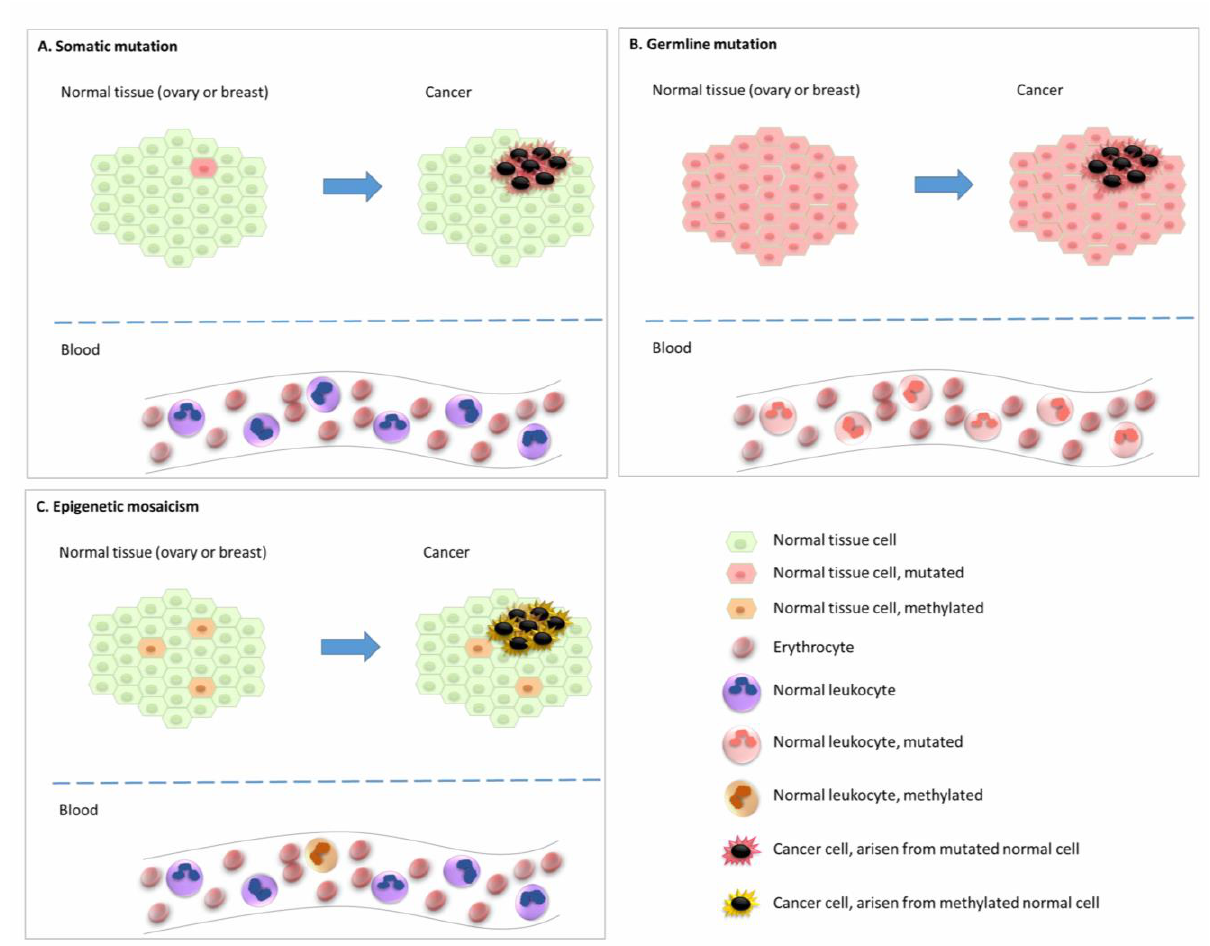
FIGURE 1: Early events underlying carcinogenesis. (A) Cancer arising from normal cells subject to a somatic driver mutation as the initial event, with subsequent alterations leading to malignant transformation. In such cases the initial event will not be detected in white blood cells (WBC). (B) Cancer arising from normal cells harbouring a germline driver mutation, acting as the initial event, with subsequent altera- tions leading to malignant transformation. In such cases the “initial event” will be detectable in all WBCs. (C) Cancer arising from a minori- ty of normal cells with a key tumour suppressor methylated from early embryonic life (epigenetic mosaicism). This methylation may act as the initial event, with subsequent alterations leading to malignant transformation. In such cases the initial event / methylation will be detectable also as mosaicism in